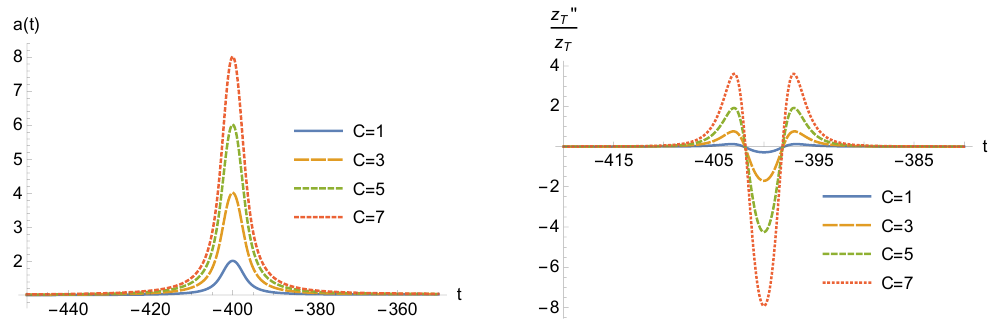
Figure 10. ( First panel ) Scale factor evolution around the bounce. From bottom to top: increasing values of C . ( Second panel ) Associated tensor